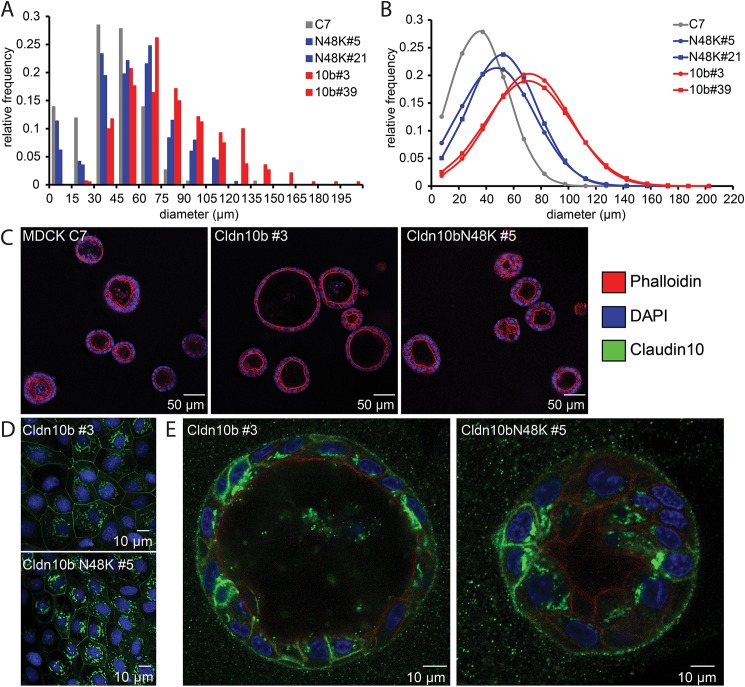
Reduced size of cysts formed by MDCK-C7 cells transfected by claudin-10b N48K.(A) Histogram of the size distribution of cyst lumen diameter (grey, untransfected control, n = 151 cysts [10 different z-stacks]; red, claudin-10b WT transfected cells: clone #3, n = 140 [9], clone #39, n = 187 [11]; blue claudin-10b N48K transfected cells: clone #5, n = 167 [9]; clone # 21, n = 113 [7]). (B) Normal distribution of the data shown in (A) to visualize the shift in lumen size in the presence of claudin-10b. (C) Representative images of cysts (red, actin-staining by phalloidin-Alexa 594; blue, nuclei stained with DAPI), (D) TJ localization of N48K and WT claudin-10b in 2D culture. (E) Presence of WT and N48K claudin-10b (green) in 3D culture (co-staining as in D).